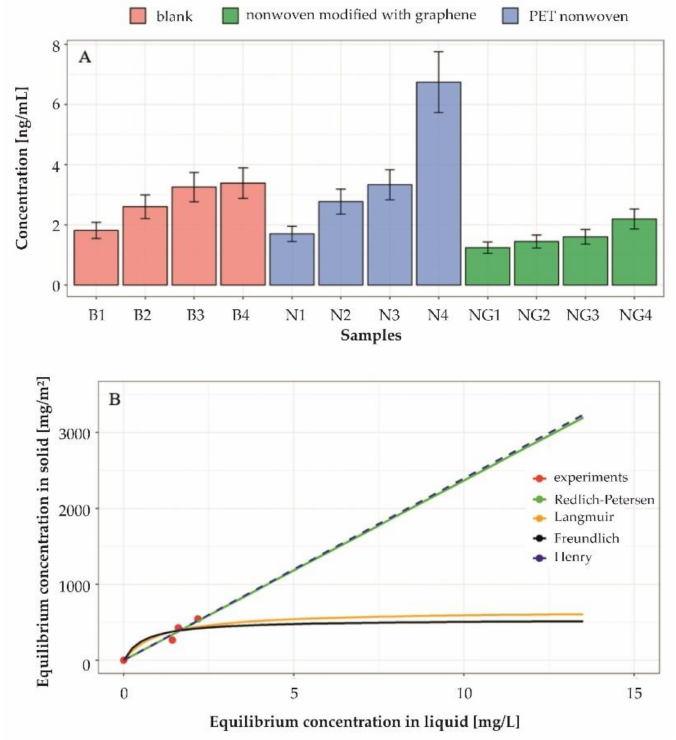
Figure 7. ( A ) Adsorption experiments for blank, nonwoven, and GMN samples for ng/mL scale, as measured via ELISA, and ( B ) the different adsorption isotherms as fits for experimental